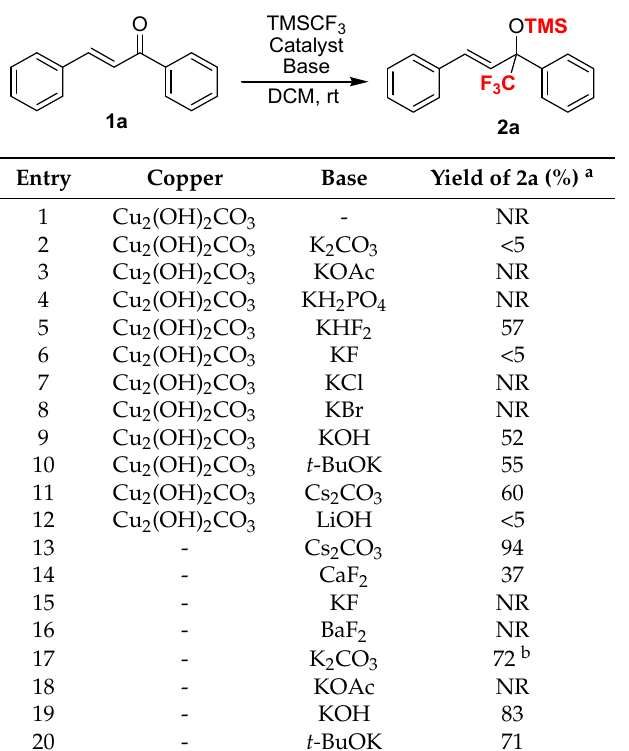
Table 1. The optimization of reaction conditions for trifluoromethylation of chalcone 1a with TMSCF 3 .